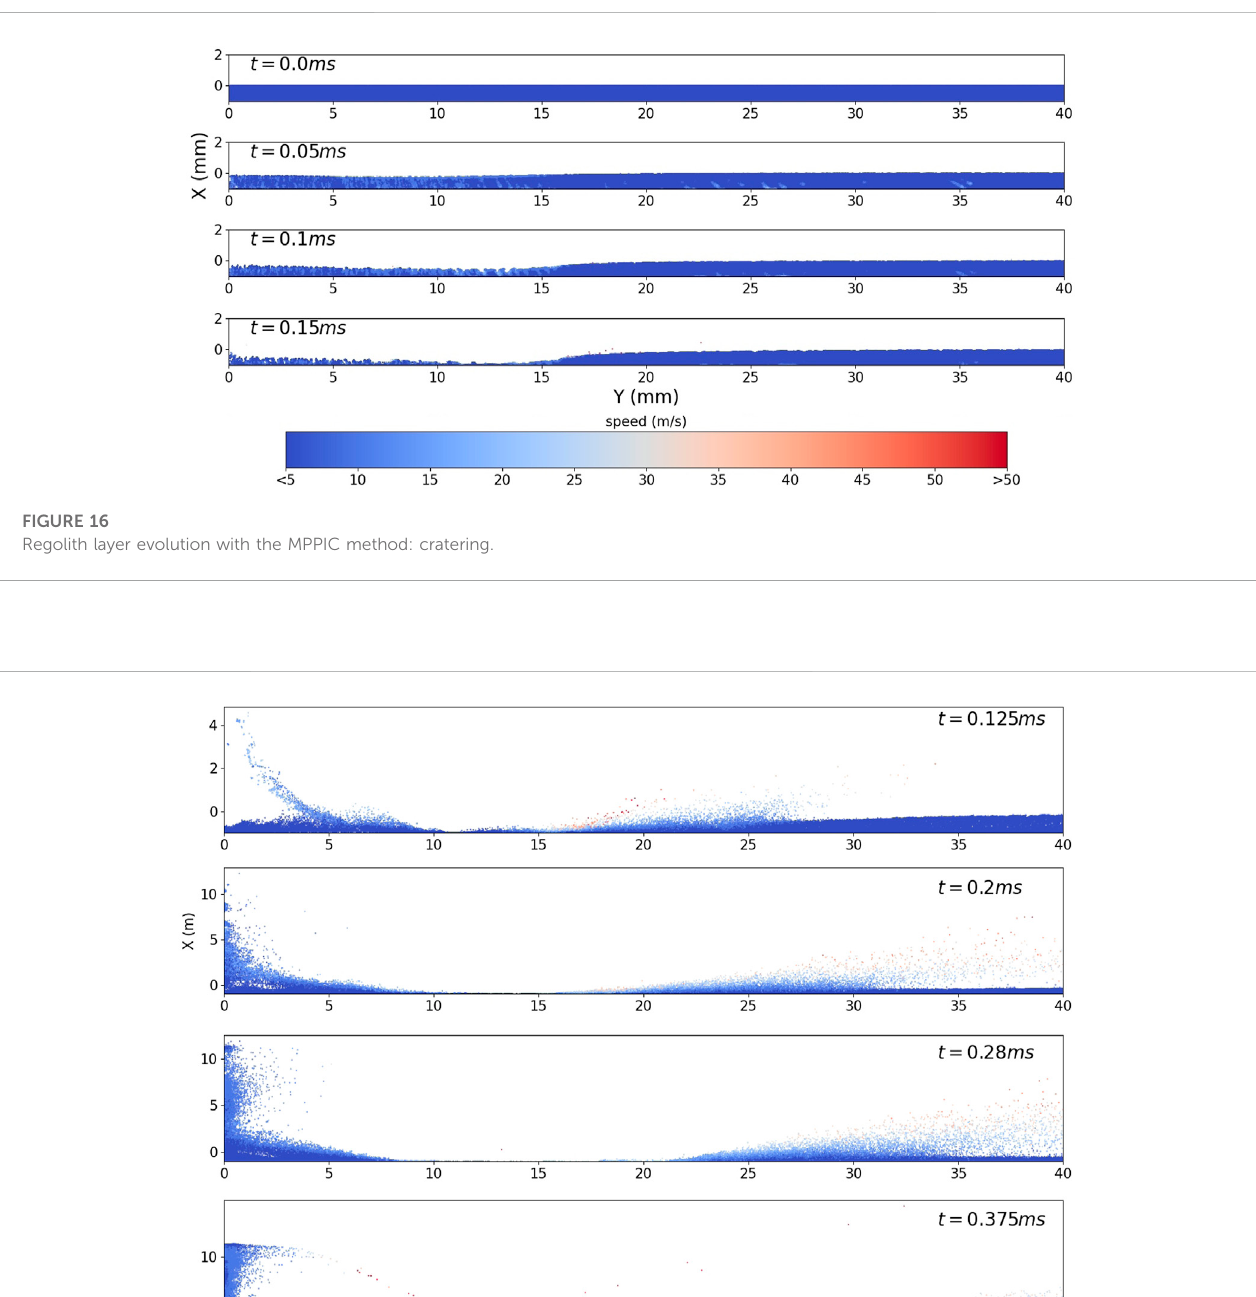
form but happens over a longer time scale with the MPPIC method and distinct structures and an uneven regolith layer surface can be observed in the solid phase. The distribution of solid particles between Y = 5 mm and Y = 10 mm is in fl uenced by the vortex, and the vortex is